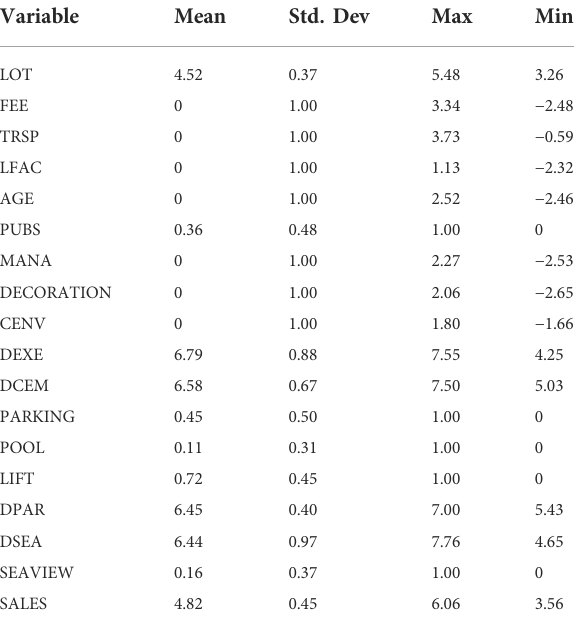
TABLE 2 Descriptive statistics of